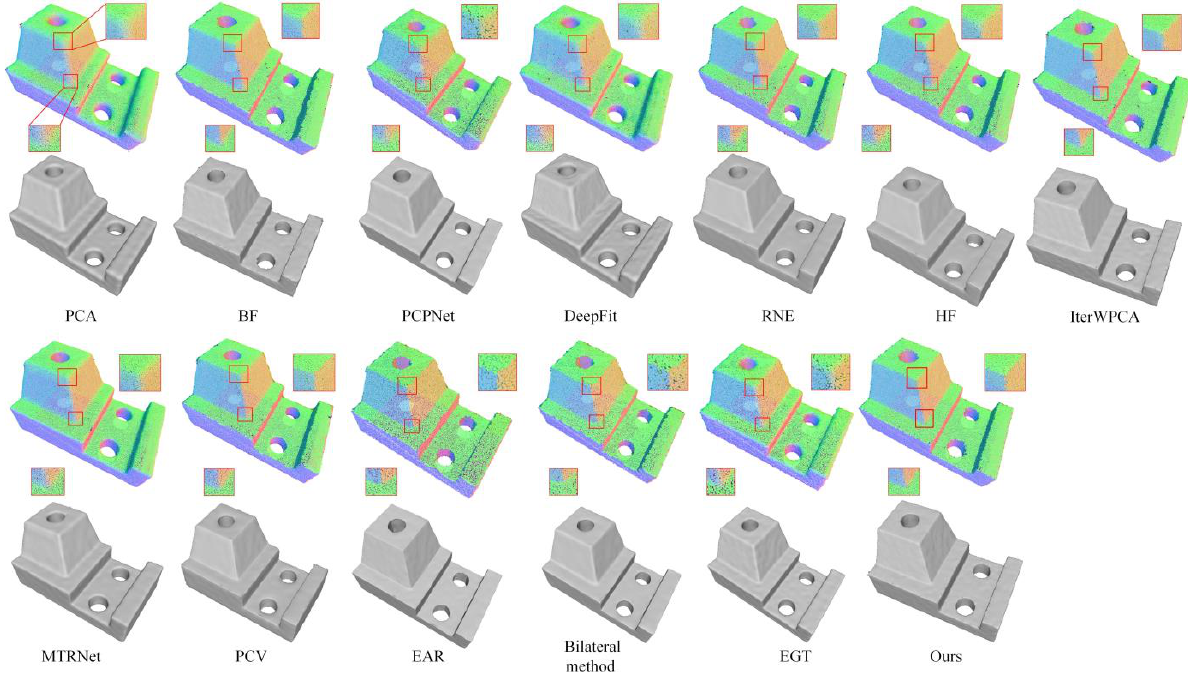
Figure 10. Comparison on point cloud filtering. First row: filtering results with upsampling. Second row: corresponding to surface reconstruction results.